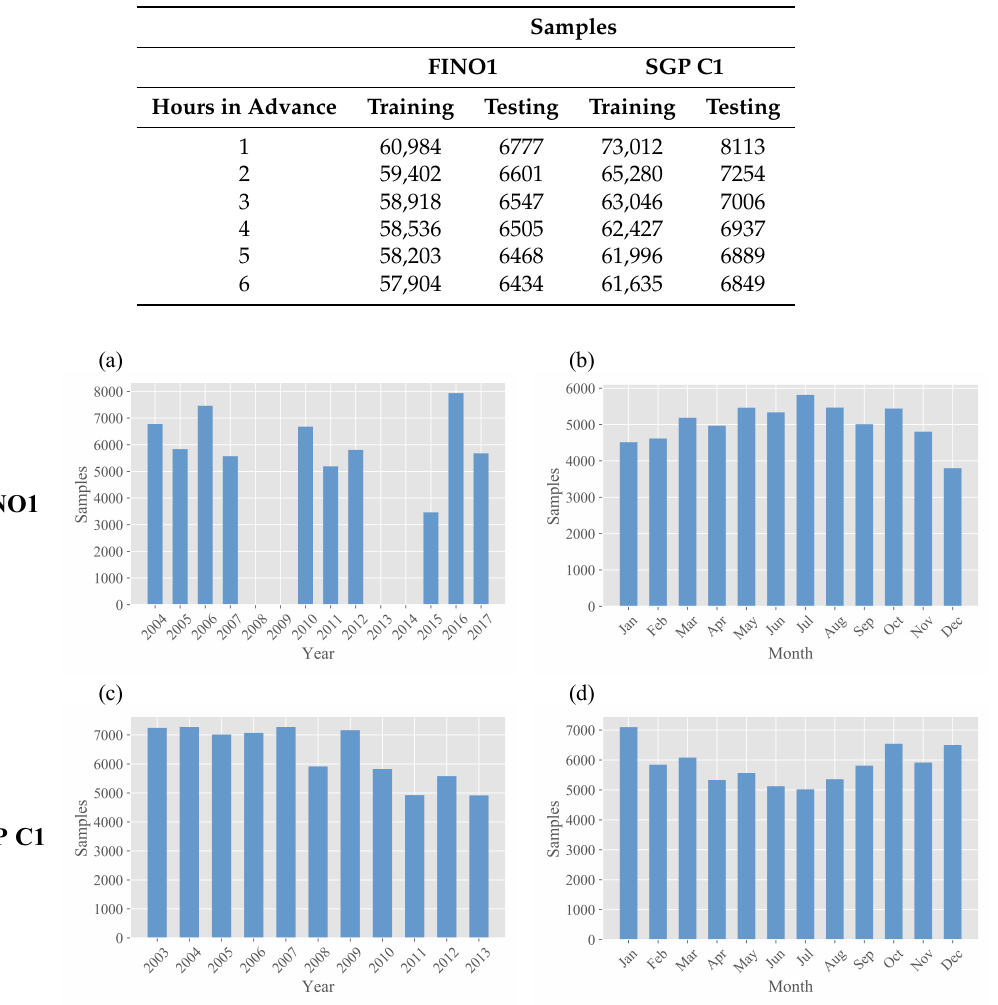
Table A1. Number of training and testing samples for each forecast. Number of overall samples decreased slightly with forecasting timescale due to decreasing data availability.